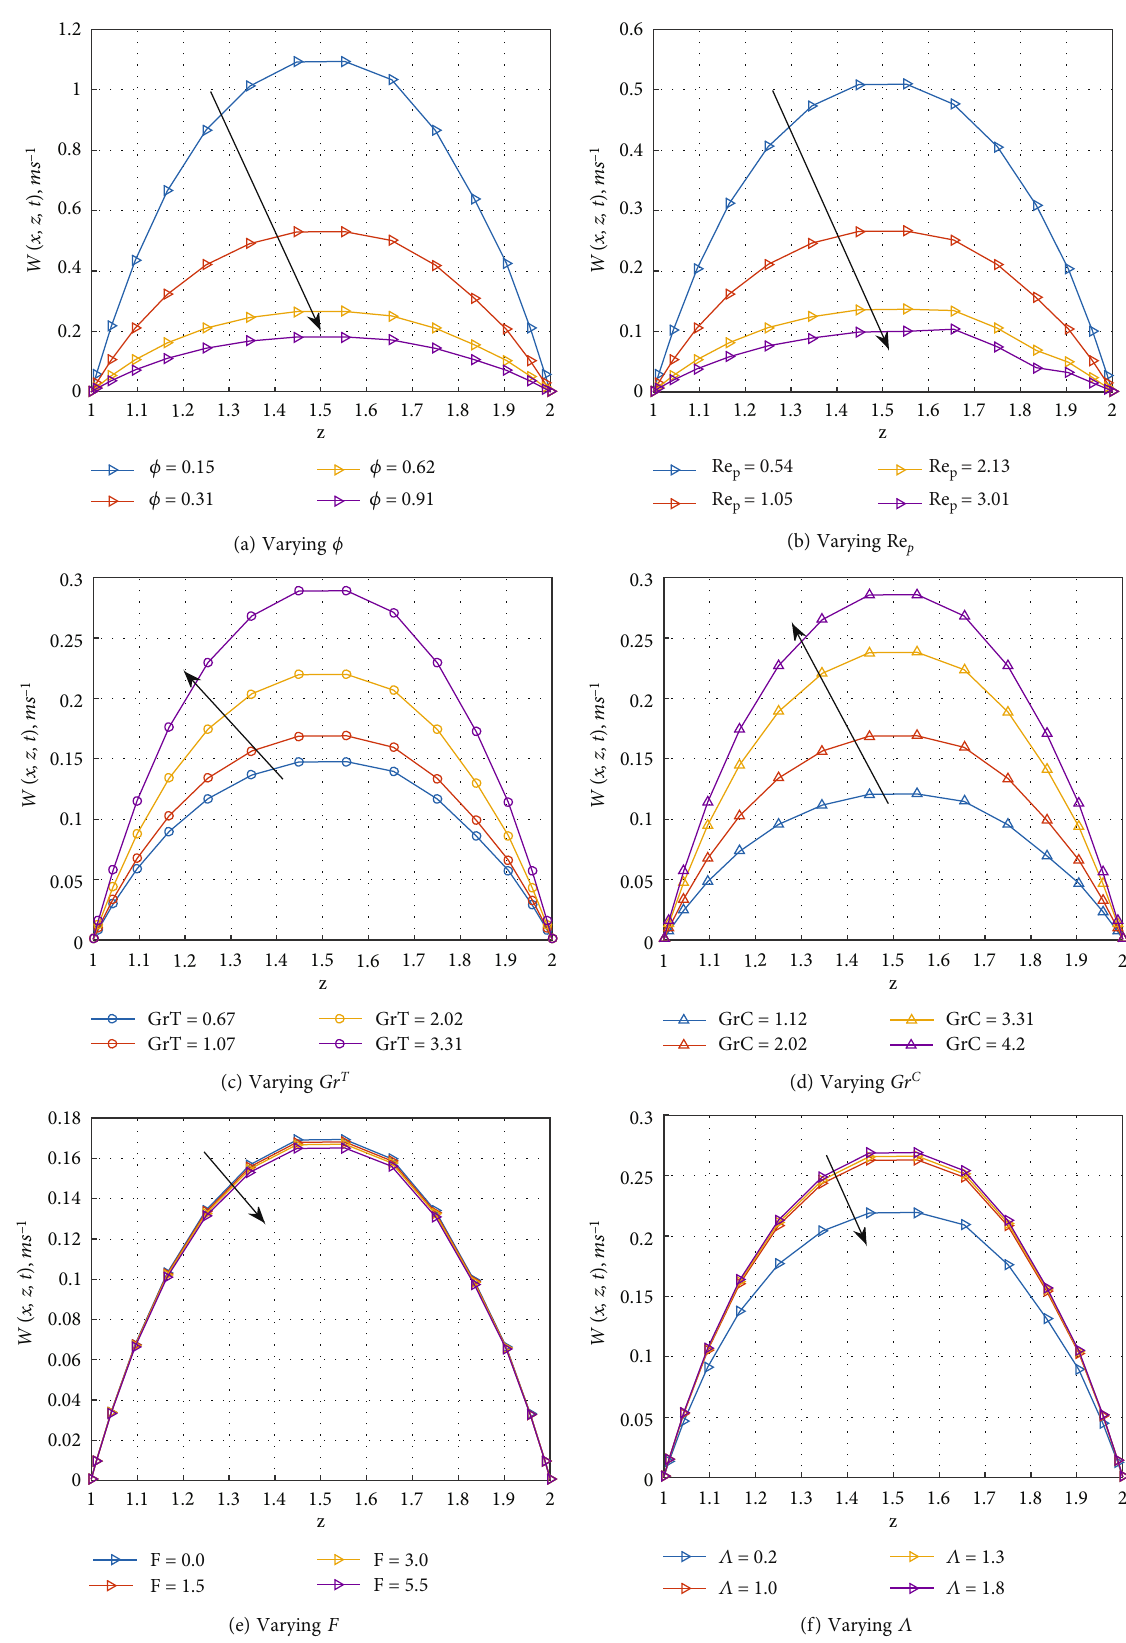
Figure 8: E ff ect of ϕ , Re , Gr T , Gr C , F , and Λ on vertical velocity fl ow pro fi p